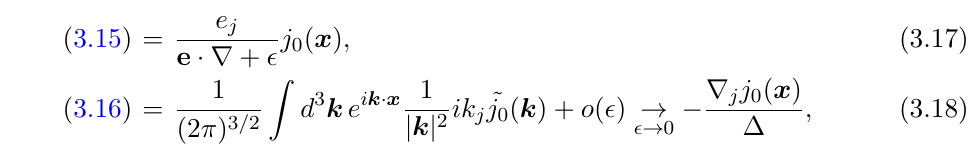
Figure 1. Contour of integration in (3.22).